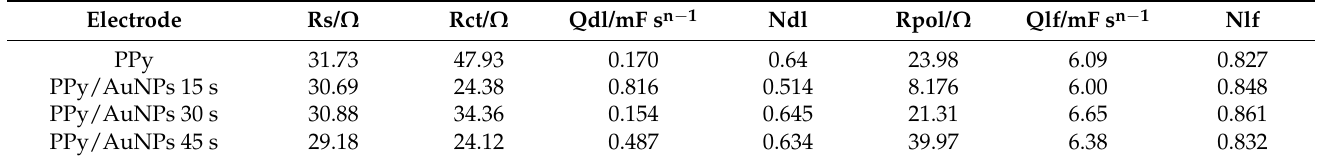
Table 1. Parameters obtained by fitting EIS data are shown in Figure 6a.